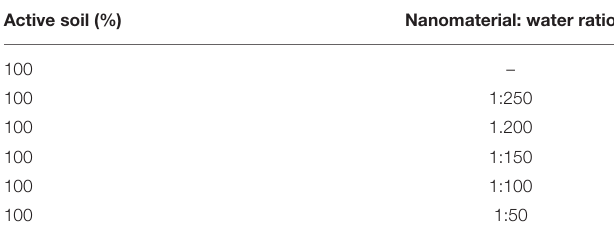
TABLE 2 | Classification of soils based on modified free swell index (after Sivapullaiah et al., 1996). Modified free swell index